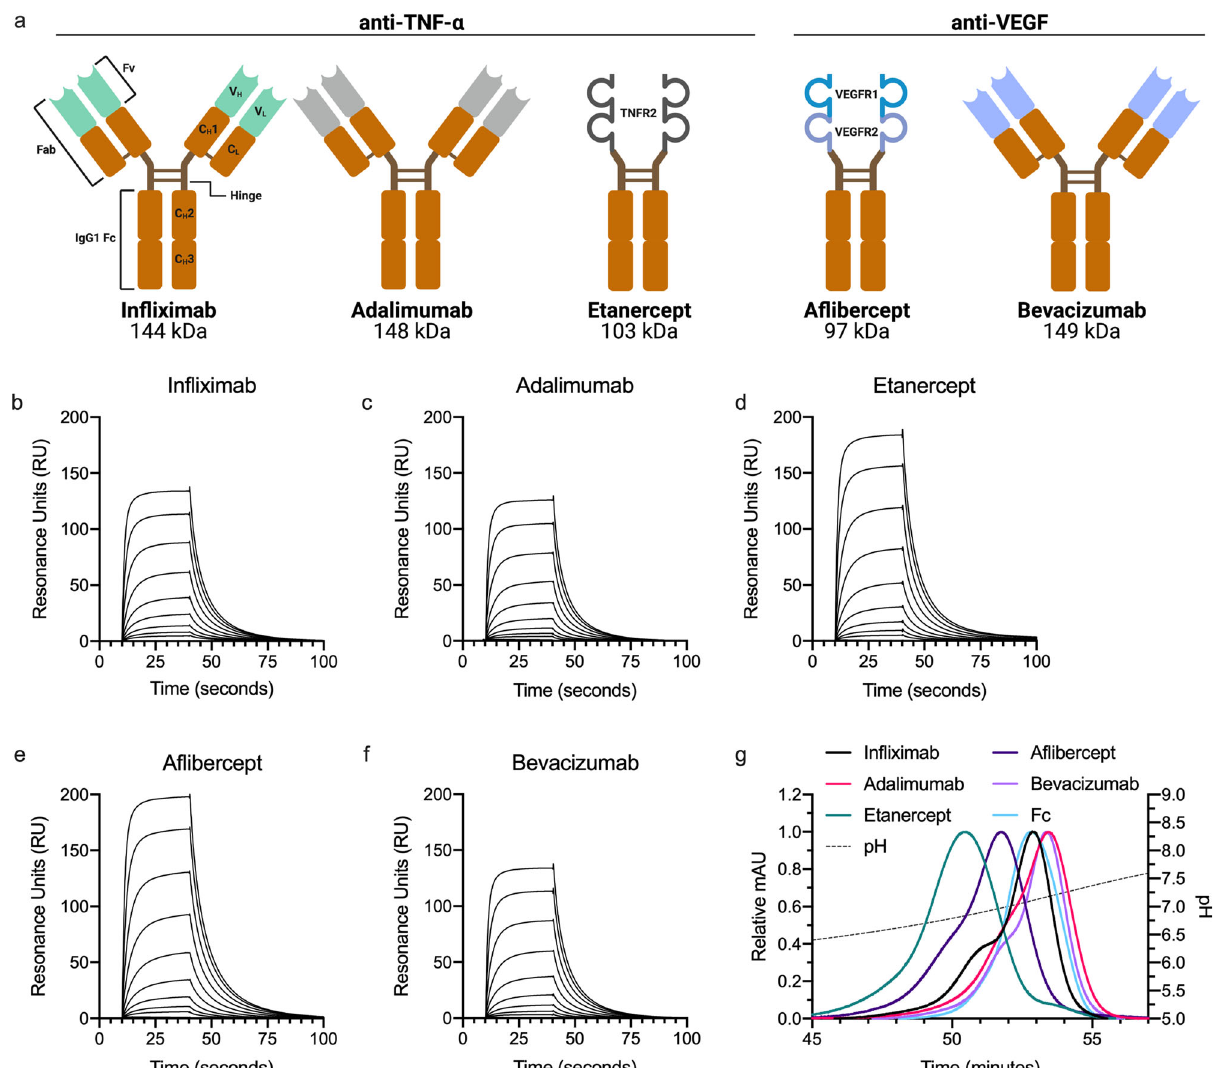
Fig. 3 Fc-fused modalities affect FcRn-binding throughout the pH-gradient. a Schematic illustration of structural elements in the ABT panel. All fi ve ABTs contain an IgG1 Fc (orange, CH2 and CH3). ABMs (Fvs and receptor domains) are marked in light green, gray or shades of blue. In fl iximab is a chimeric mouse-derived human IgG1 with a murine Fv (marked in light green) binding to TNF-a. Adalimumab is a fully human IgG1 binding to TNF-a (Fv gray). Etanercept consists of the extracellular domains of TNFR2 (gray) fused to the IgG1 Fc via a hinge region. A fl ibercept consists of D2 of VEGFR1 (turquoise) linked to D3 of VEGFR2 (light blue) fused to an IgG1 Fc. Bevacizumab is a fully human IgG1 binding to active isotypes of VEGF (Fv light blue). MW of the total amino acid sequence of each ABT is indicated. b – f Representative SPR sensorgrams of titrated amounts of monomeric FcRn injected over immobilized ABTs (~400 RU). g Elution pro fi les of ABTs from FcRn chromatography shown as relative fl uorescence intensity throughout the pH gradient. The pH is plotted on the right Y -axis and indicated by a stapled line. Color labeling; in fl iximab (black), adalimumab (pink), etanercept (teal), a fl ibercept (dark purple), bevacizumab (light purple), Fc (light